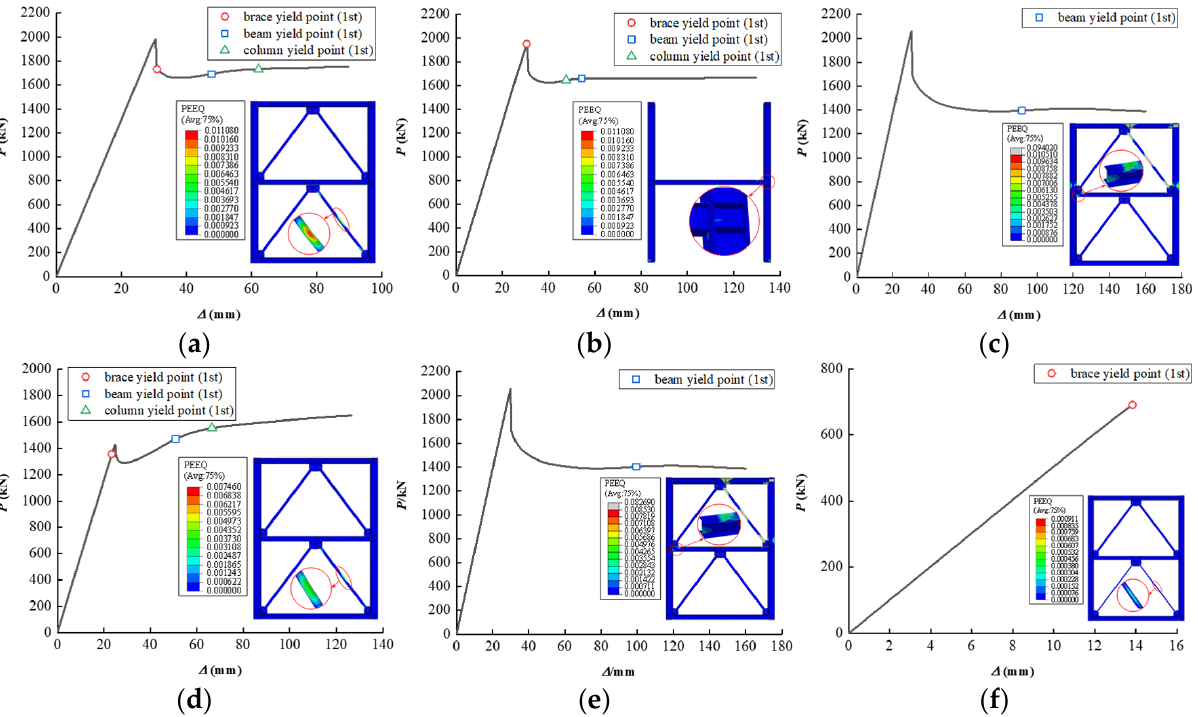
Figure 9. The predicted PEEQ distributions of concentrically ‐ braced steel frames with different parameters (typical floor and η = 0). ( a ) case 7, the basic model obtained by the proposed method; ( b ) case 8, with a smaller ‐ section column web; ( c ) case 9, with increased brace thickness; ( d ) case 10, with decreased brace thickness relative to the basic model; ( e ) case 11, with braces with larger external diameter; ( f ) case 12, with braces with smaller external diameter.